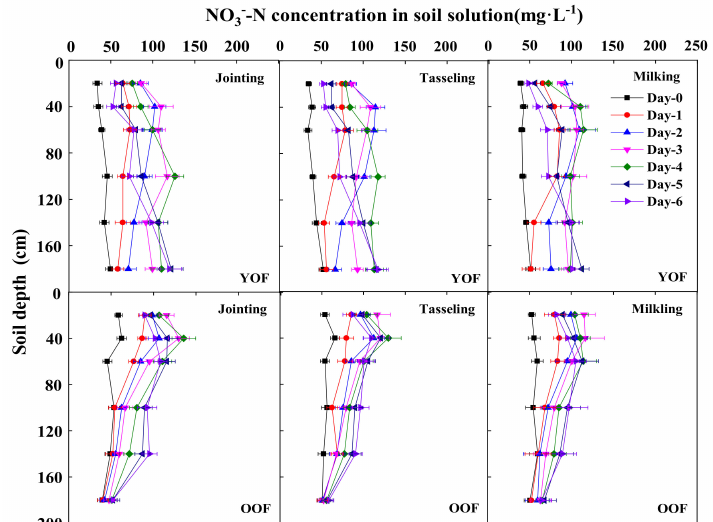
Figure 5. NO 3 − -N concentrations in soil solution after N input was measured at three maize growth stages during 2020. Error bars represent standard deviation. Day zero represents measurements on the day before nitrogen application.